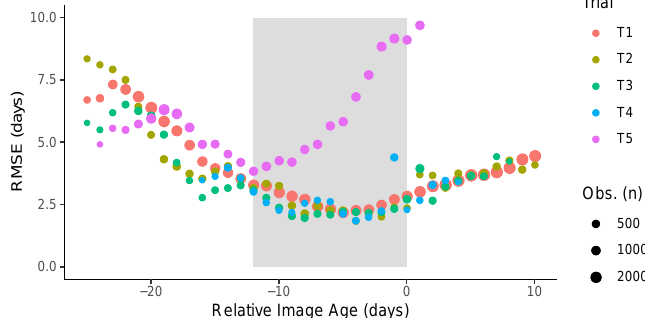
Figure 7. Prediction performance measured by the root mean squared error (RMSE) as a function of the difference between the image acquisition date and the ground truth maturity date. The shaded area represents the time window comprising the five images with the least error.